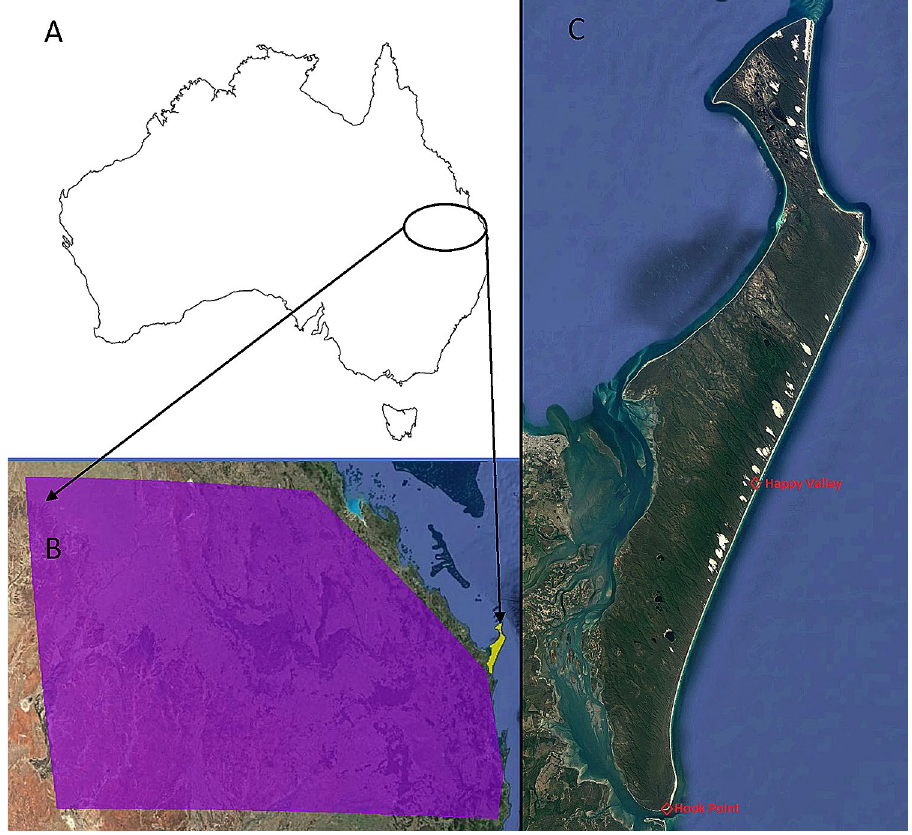
Figure 1. ( A ) The general study region in Australia ( B ) the mainland sampling region (shaded purple) adjacent to K’gari (shaded yellow), ( C ) K’gari-Fraser Island, with Hook Point and Happy Valley indicated. Maps were